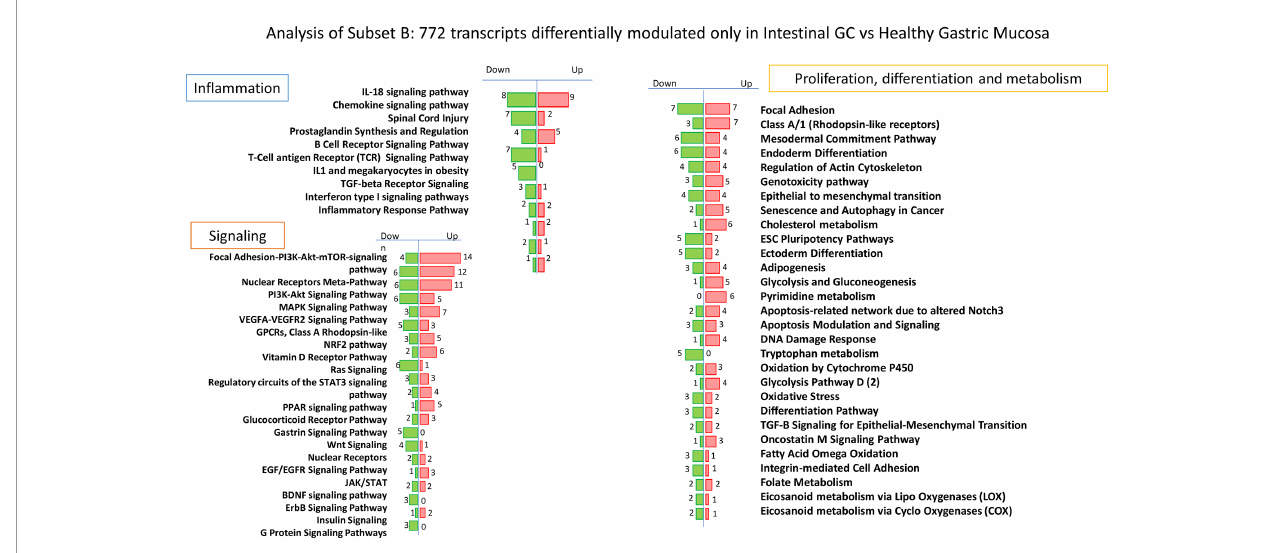
FIGURE 4 | Per pathways analysis of Subset B Analysis of 772 transcripts differentially modulated only in Intestinal Gastric Cancer vs Healthy Gastric Mucosa: identi fi cation of several pathways that can be grouped in three principal clusters: Proliferation, differentiation and metabolism, In fl ammation and